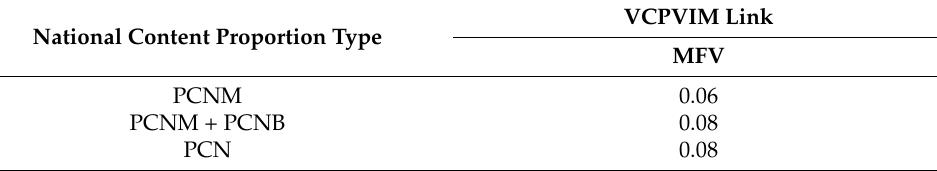
Table 8. Proportion of national content of the VCPVIM in the reference year.